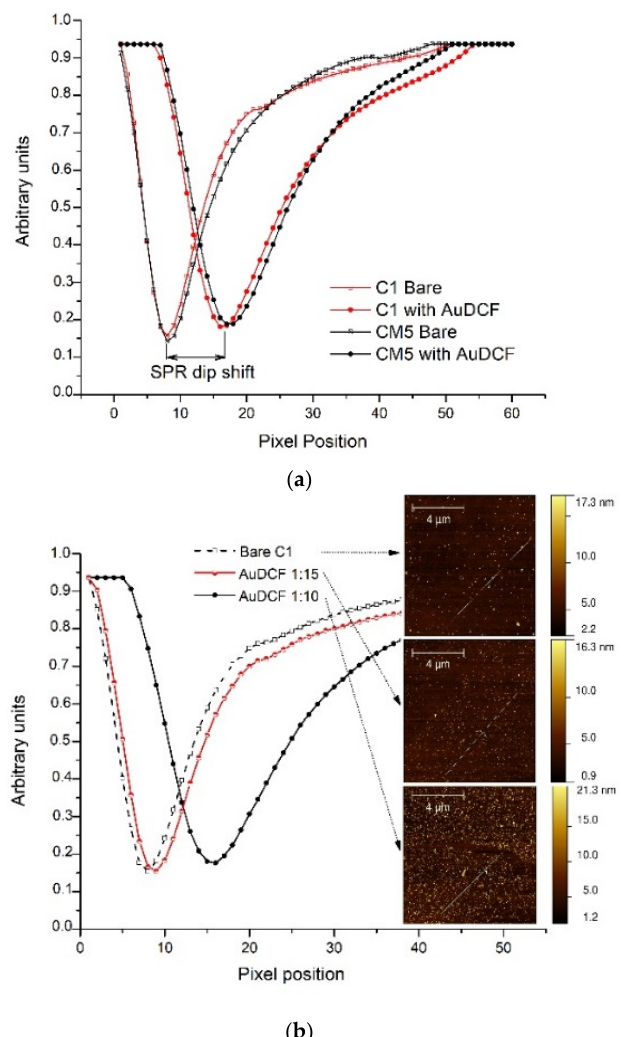
Figure 2. ( a ) SPR curves recorded on C1 and CM5 chips showing successful attachment of Au-DCFs; ( b ) SPR curves recorded on C1 for Au-DCFs with different gold to dynamer ratios—Inset AFM scans on each surface revealing Au-DCF aggregates on the corresponding surfaces.